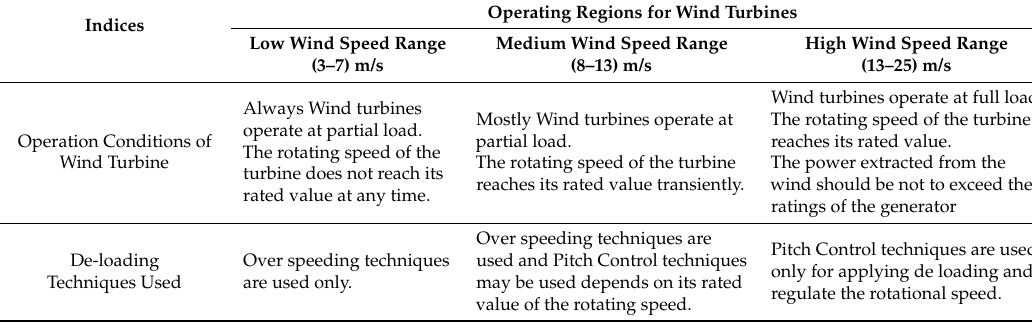
Figure 21. The ( P - ω ) curve when applying pitching control for a wind turbine at speed 10 m/s. Table 2. De-loading techniques based on the range of the level speed.